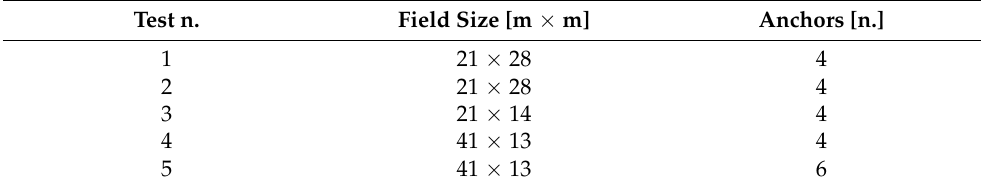
Table 7. Test 1–5 configurations.